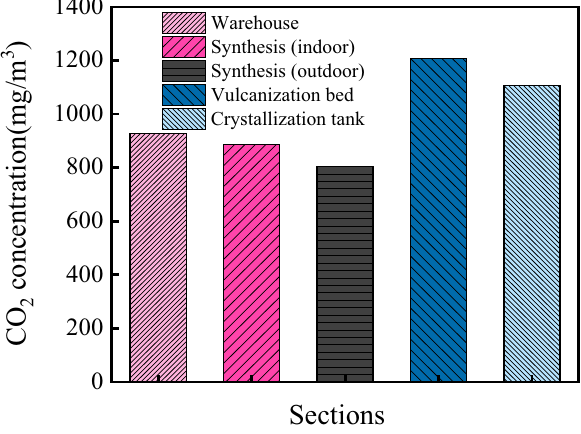
Figure 4. CO 2 concentration in the ammonium sulfate